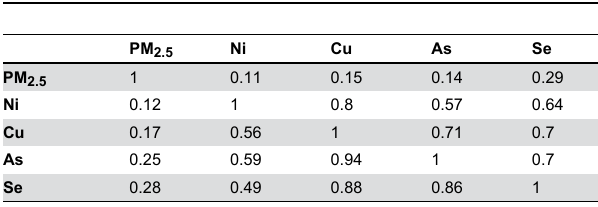
Table 1. Correlation Matrix of Personal Exposures to PM and key metal concentrations (n=57).